Question: Reading the figure, is the described quantity rising or falling?
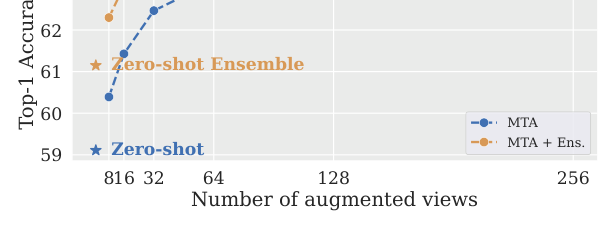
Answer: increasing